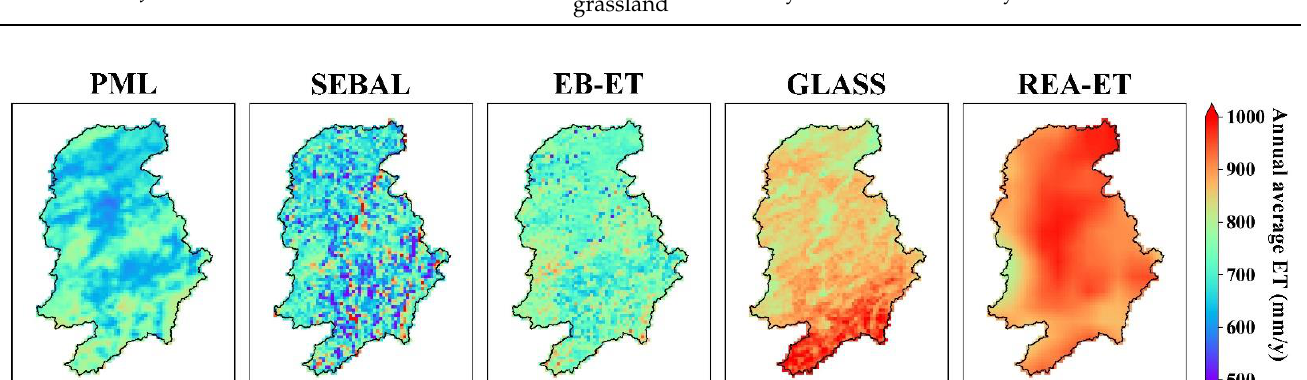
Figure 2. Spatial patterns of annual average evapotranspiration (ET) from five selected ET datasets in the GRB. Table 3. Summary of ET datasets.